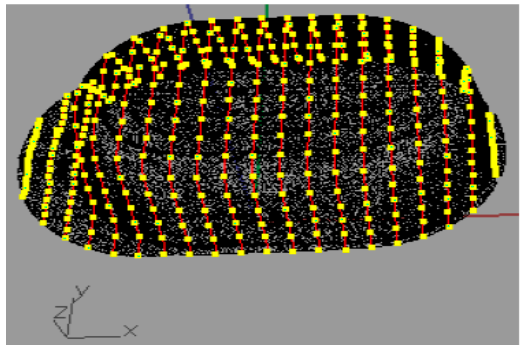
Figure 12. V-direction Spatial Path.